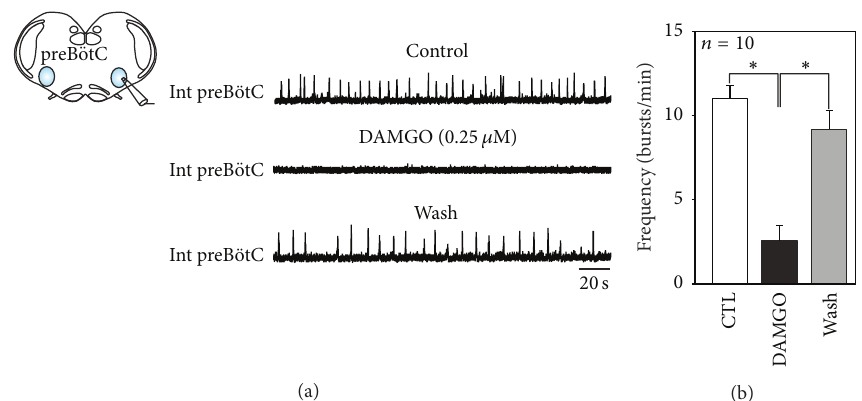
Figure 2: DAMGO-dependent modulation of the embryonic respiratory rhythm. (a) Schematic of an embryonic transverse brainstem slice used for extracellular electrode recording from the isolated preB¨otC network. Integrated network activity (Int preB¨otC) recorded in control conditions (top), in the presence of 0.25 𝜇 M DAMGO (middle) and after 30 minutes’ wash-out (bottom). (b) Pooled data showing mean ( ± SEM) inspiratory burst frequency obtained from 10 embryonic slices in control conditions (CTL, white bar), after 15min exposure to 0.25 𝜇 M DAMGO (black bar) and after wash-out (gray bar). DAMGO significantly decreased the preB¨otC rhythm frequency. This effect was reversible. Asterisk indicates 𝑃 < 0.05